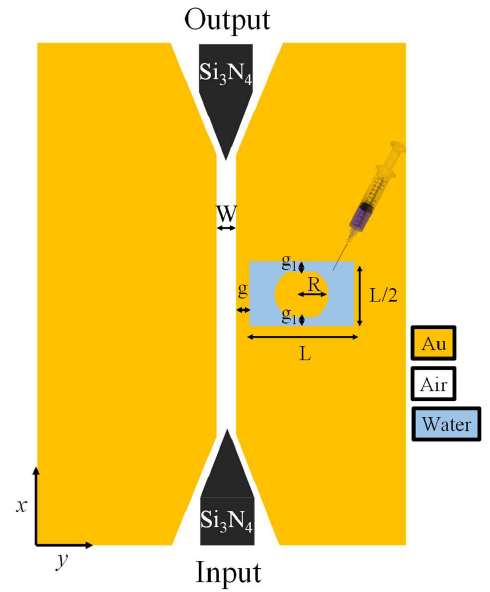
Figure 5. Schematic representation of the MIM waveguide-based plasmonic sensor integrated with dielectric mode converters.